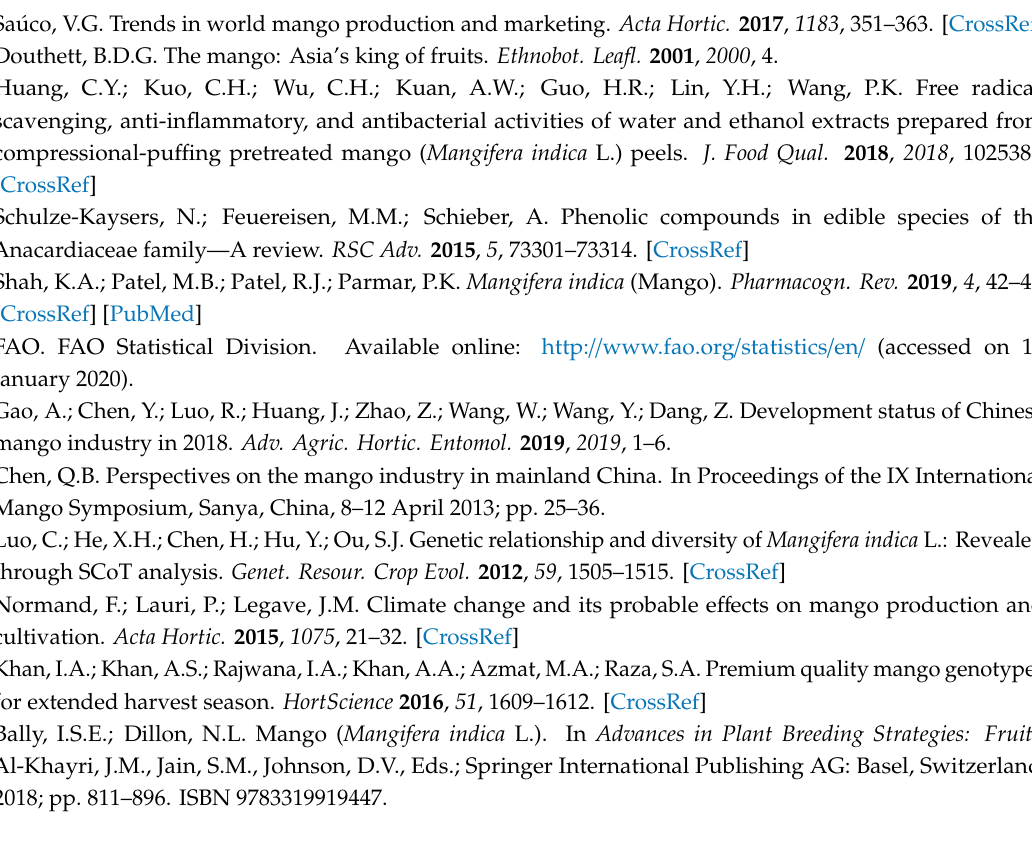
Table S1, distribution of qualitative traits; Table S2, correlation matrix of the quantitative descriptors; Table S3, description of the clusters based on proportion (%) of categorical